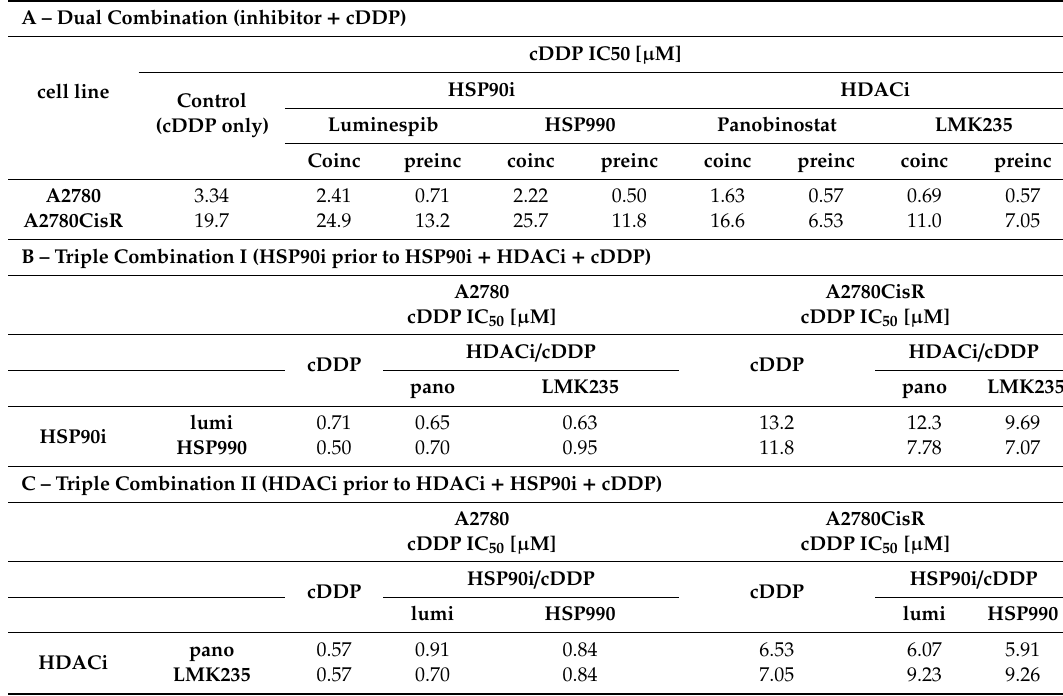
Table 2. Influence of dual or triple combinations with HDACi or HSP90i on the cytotoxic activity of cisplatin in A2780 and A2780CisR